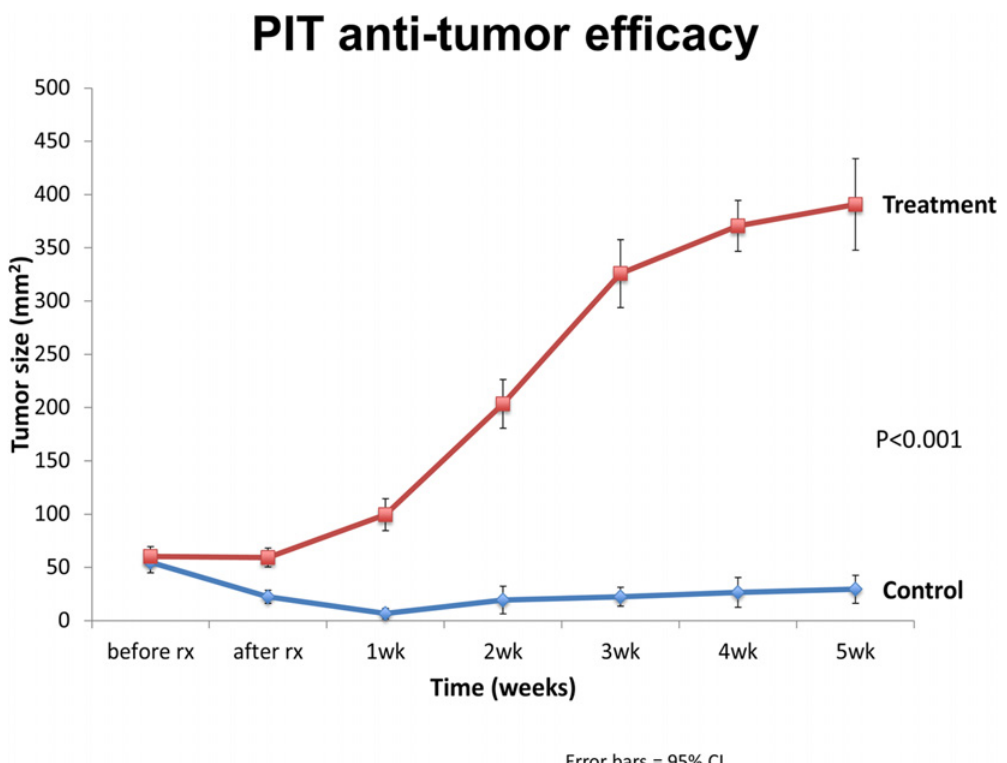
Fig 5. Graphical representation of tumor size over 5 weeks. Tumor sizes were determined using image-J software (National Institutes of Health, Bethesda,